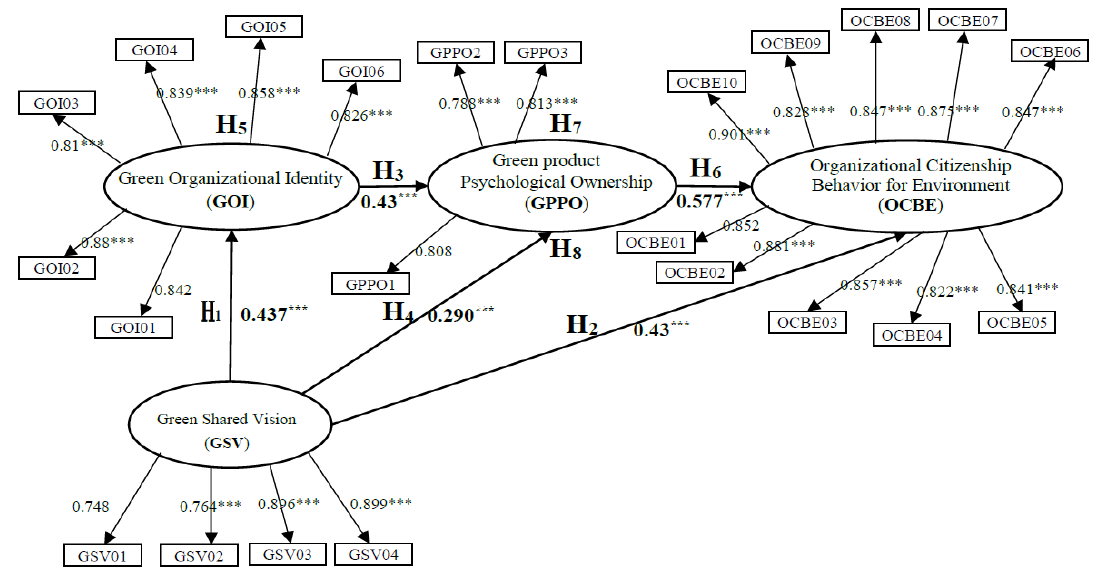
Figure 2. Results of the full model. chi square / df = 2.928, GFI = 0.886, RMSEA = 0.064, NFI = 0.956, CFI = 0.956. Note: *** p < 0.001.